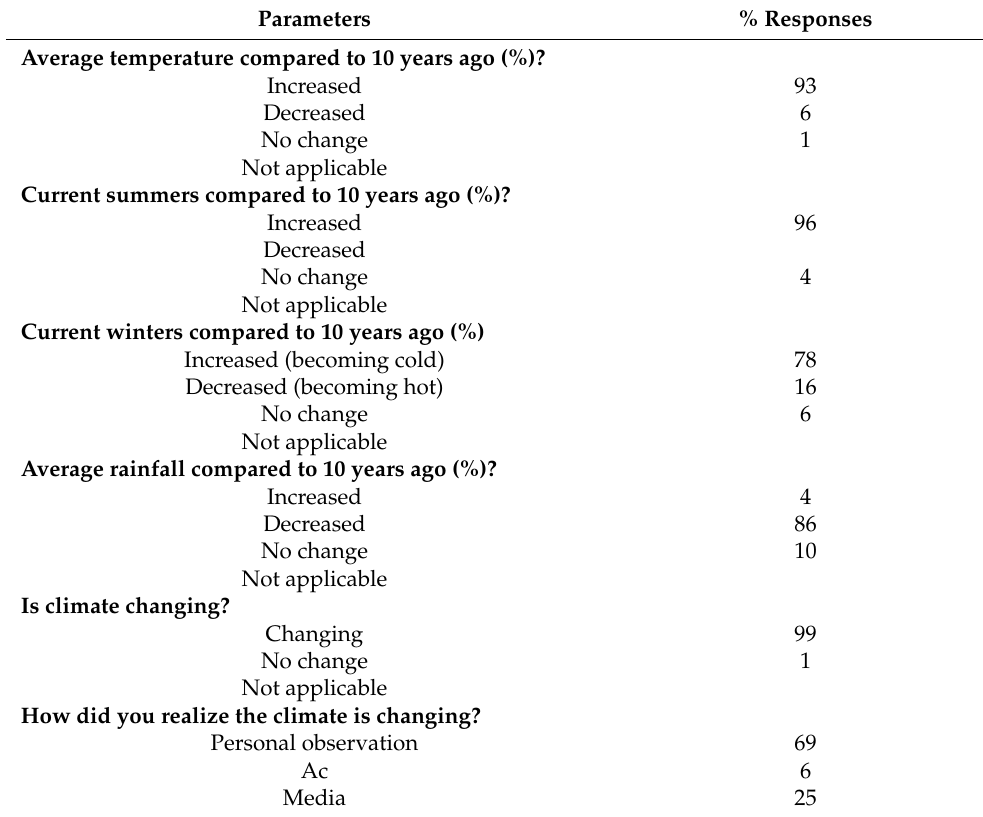
Table 8. Perception about climate change and variability. Parameters %